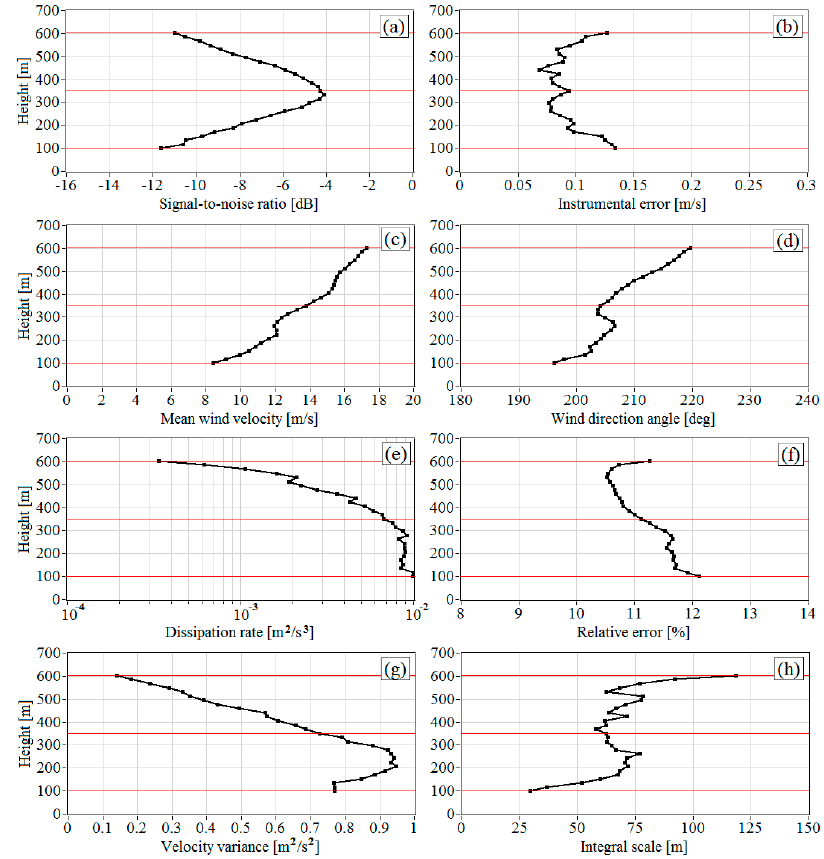
L ( h )  ( b ), U ( c ),  ( d ),  ( e ), E  ( g ), and ( f ), 2 e V V  w